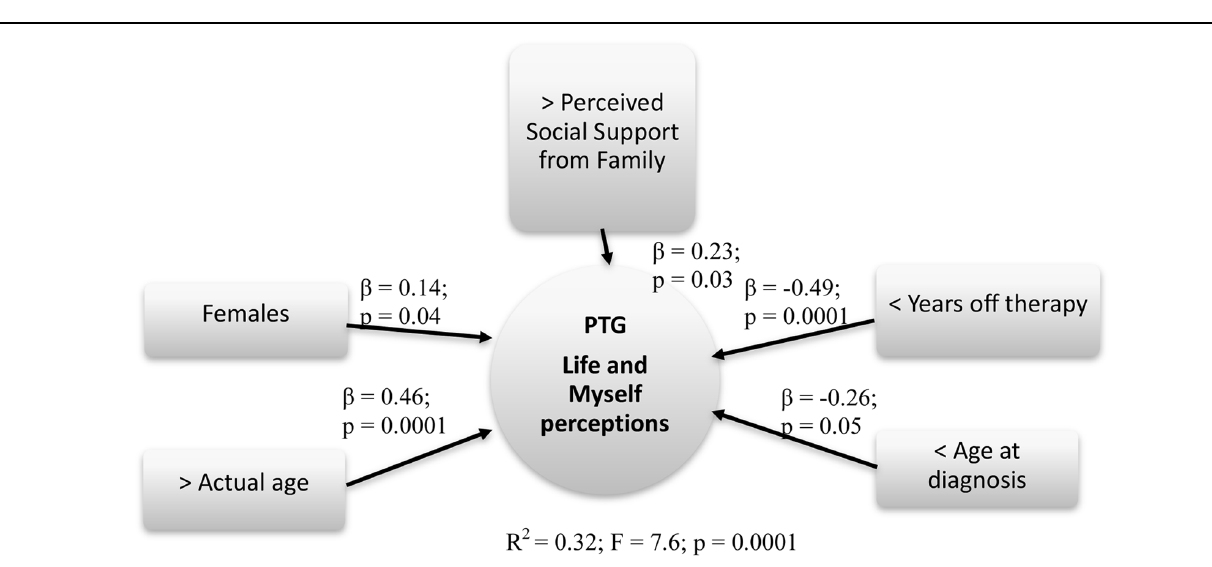
FIGURE 4 | Predictive factors of PTG life and myself perceptions. Rectangle: stable Independent variables; Square: modifiable Independent variables; Circle: Dependent